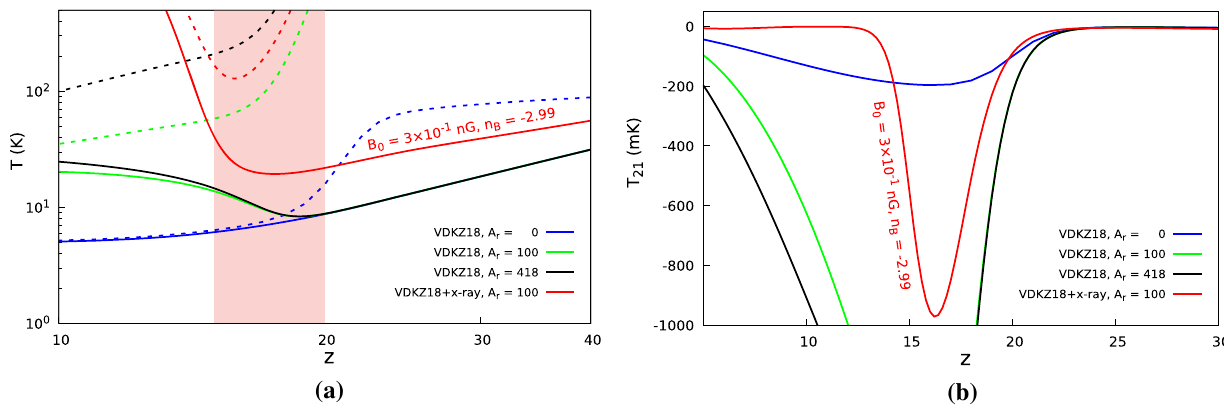
Fig. 2 Plot a shows the gas (solid lines) and spin (dashed lines) temperature evolution, The shaded region corresponds to the redshift 15 ≤ z ≤ 20 – the redshift range for EDGES reported signal. Plot b , shows the 21 cm differential brightness temperature with redshift for same cases in plot